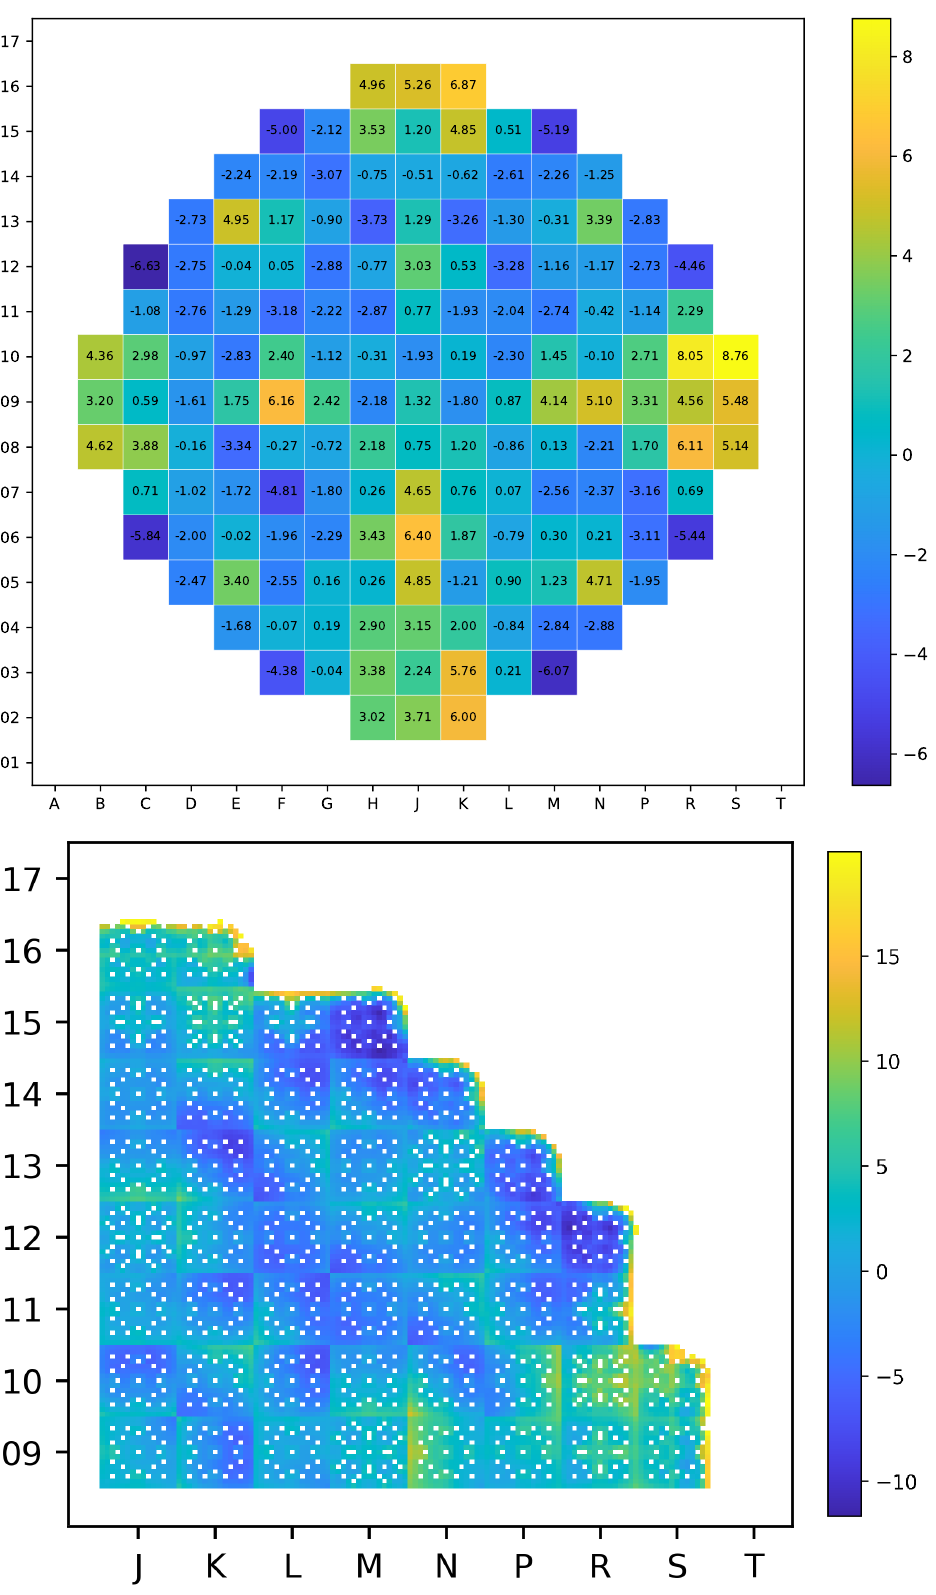
Figure 7. Relative differences (%) between the cycle-averaged fission neutron distributions evaluated − α with the α and β approaches ( β ). Differences are presented at the assembly scale ( top ) and at the α fuel-pin scale ( bottom ). For pin-scale differences, only values less than or equal to 20% are displayed, for viewing